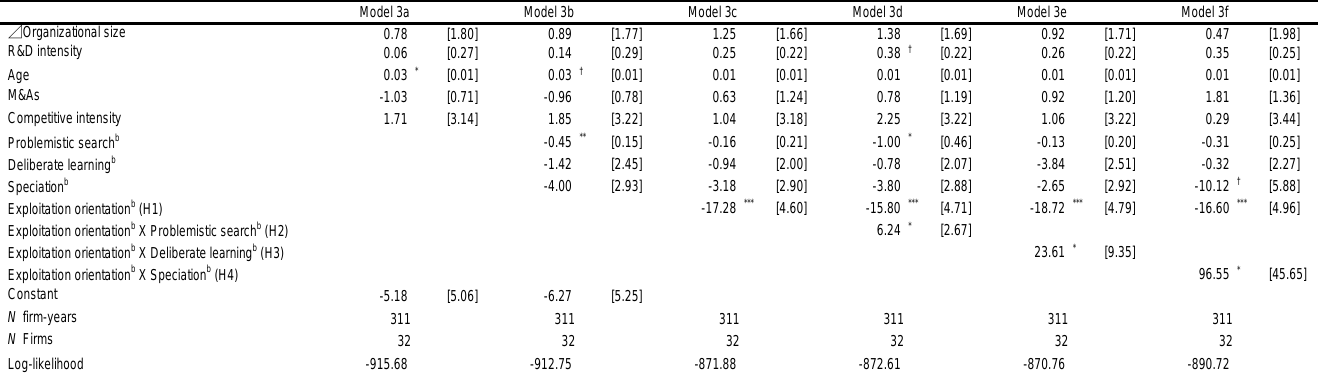
Table 3. Results of the CUE (continuous-updating estimator) regression analysis for the effects of exploitation orientation on increases in organizational